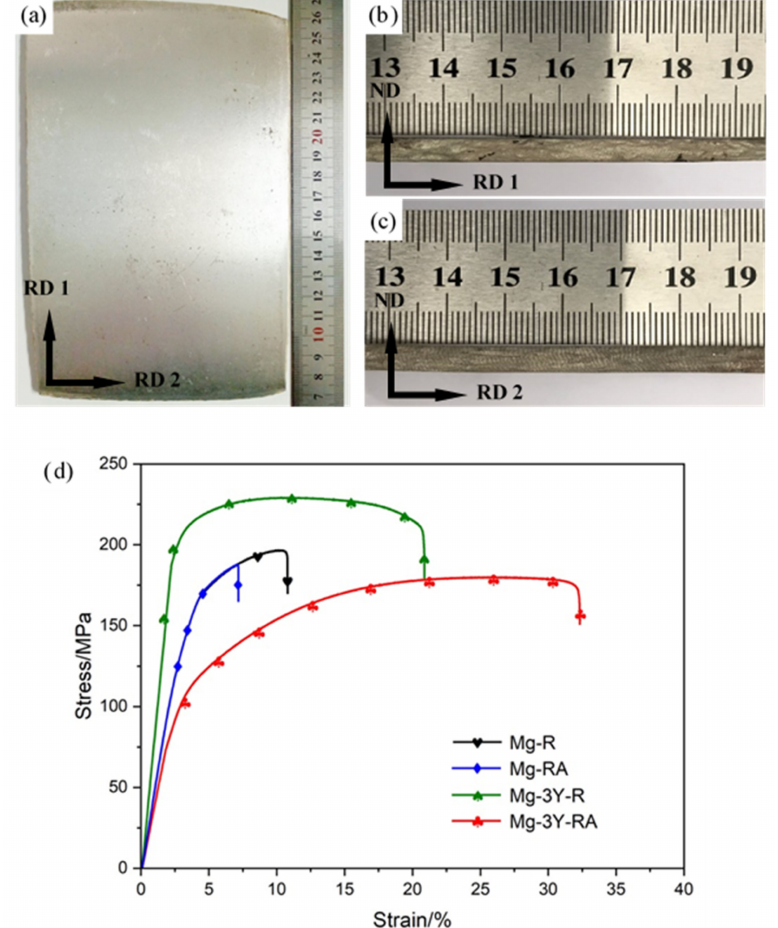
Figure 23. Macro-morphologies of as-rolled Mg-3Y alloy sheet obtained from ( a ) RD1-RD2 plane, ( b ) RD1-ND plane, ( c ) RD2-ND plane, and ( d ) typical engineering stress-strain curves of tensile test for all sheets at room